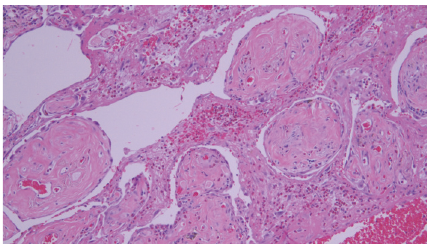
Figure 3: Picture of the lung tissue obtained showing chronic inflammatory changes, dense fibrinous airspace exudates, areas of organization, and prominent eosinophils, consistent with eosinophilic pneumonia.